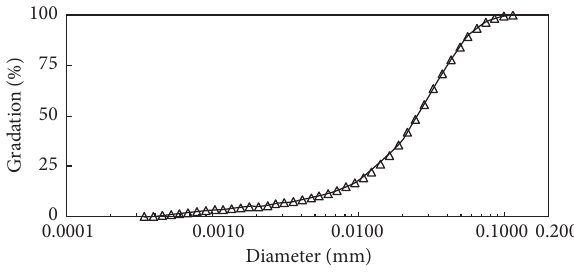
Figure 2: Granular analysis of loess samples. Table 1: Physical property of loess samples and loading conditions of static/dynamic triaxial